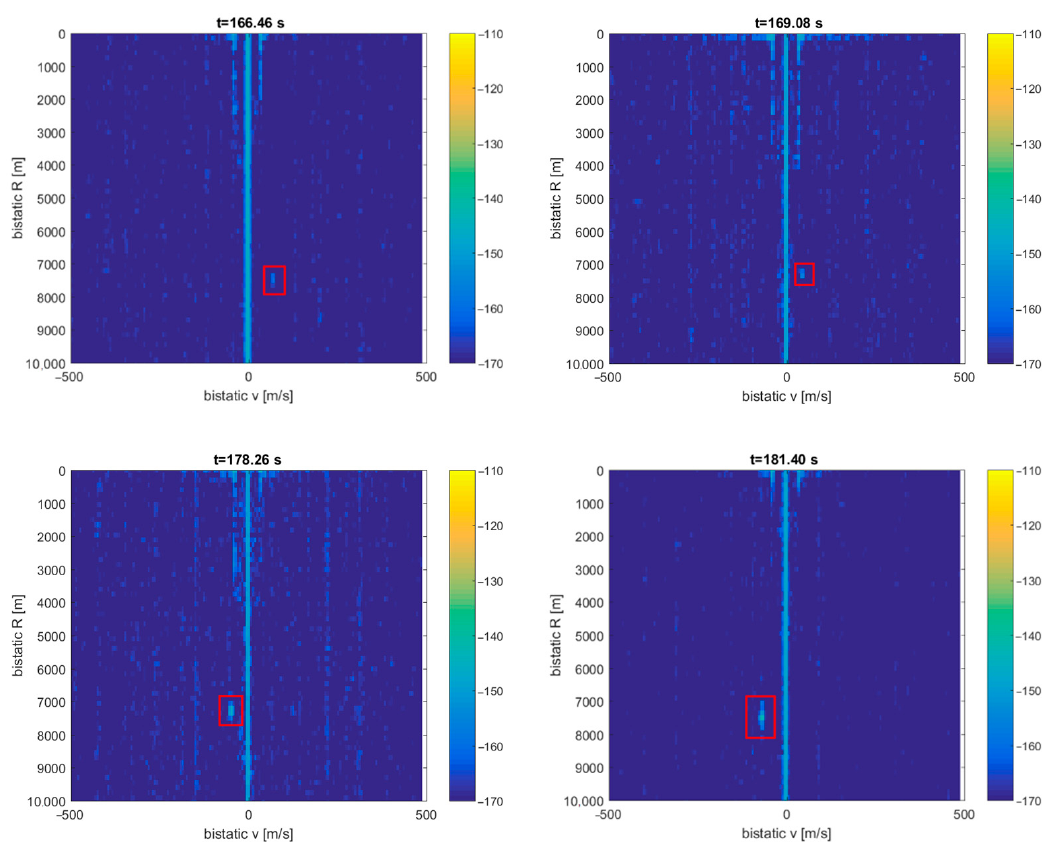
Figure 19. Detection results of the SUI812/PILATUS PC-12 aircraft (scene in Figure 18).